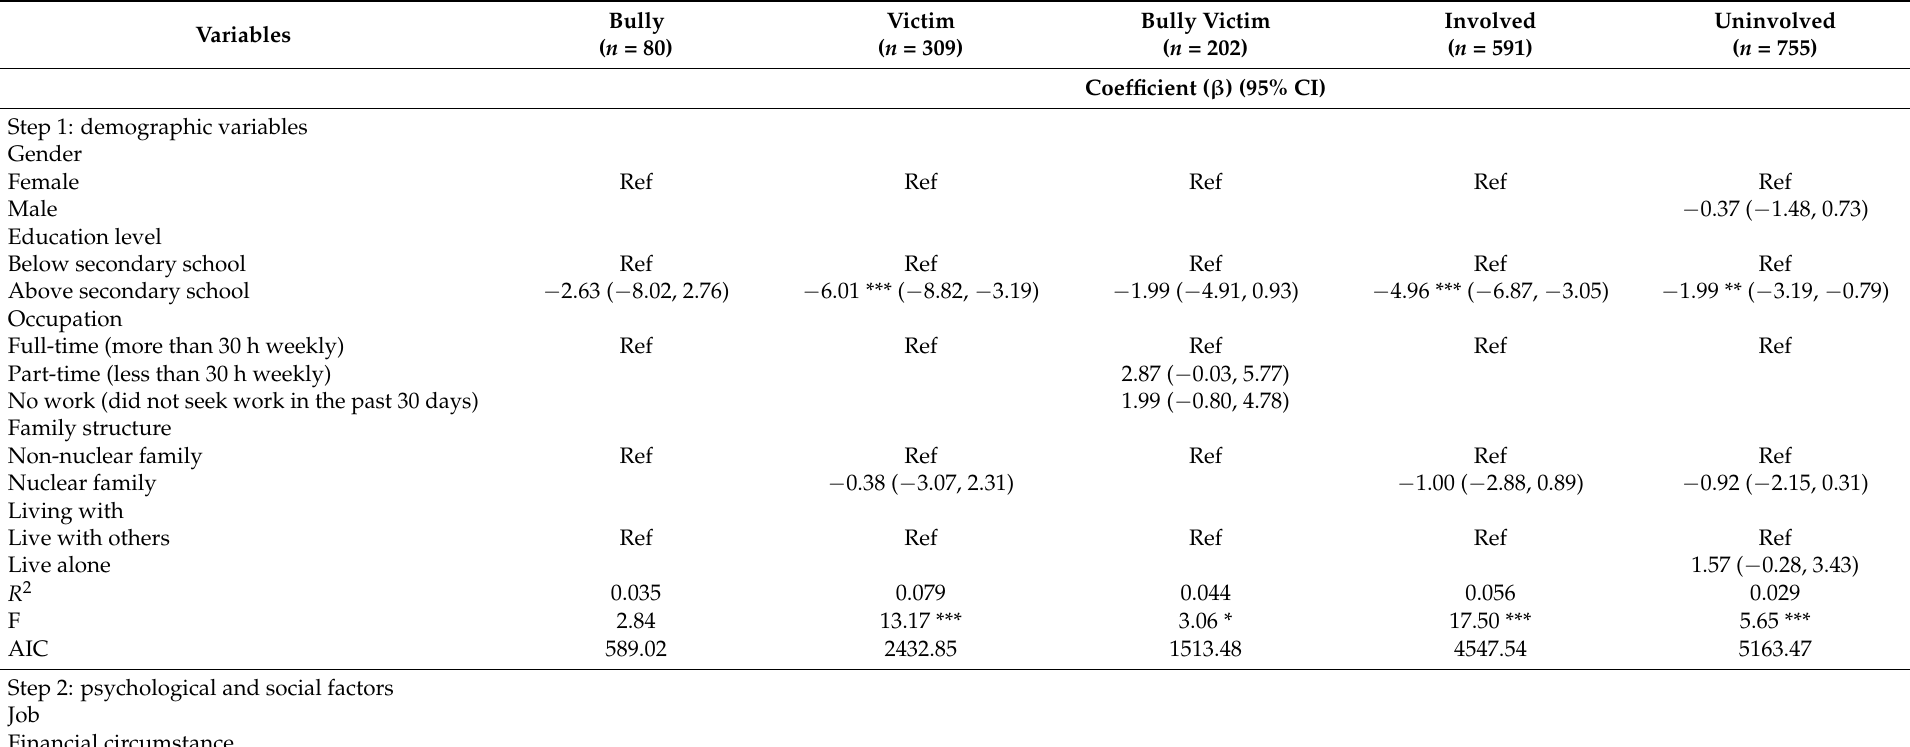
Table 3. Summary of hierarchical multiple linear regression predicting SIDAS